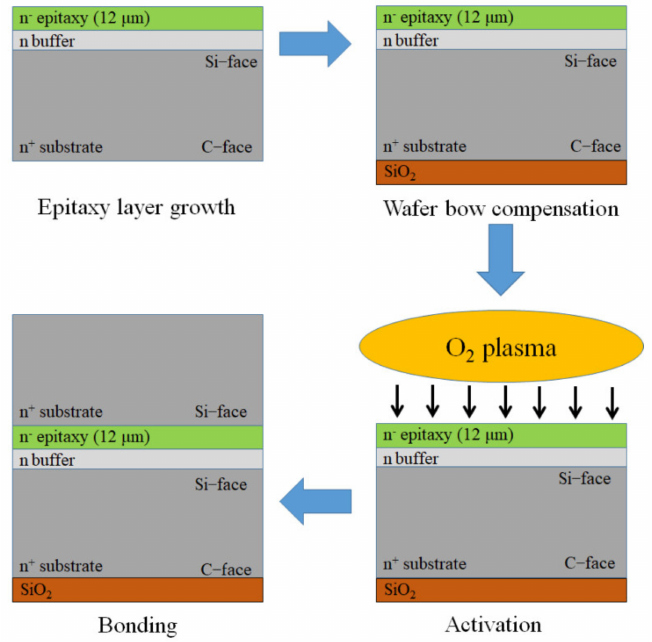
Figure 2. Schematics showing of bonding